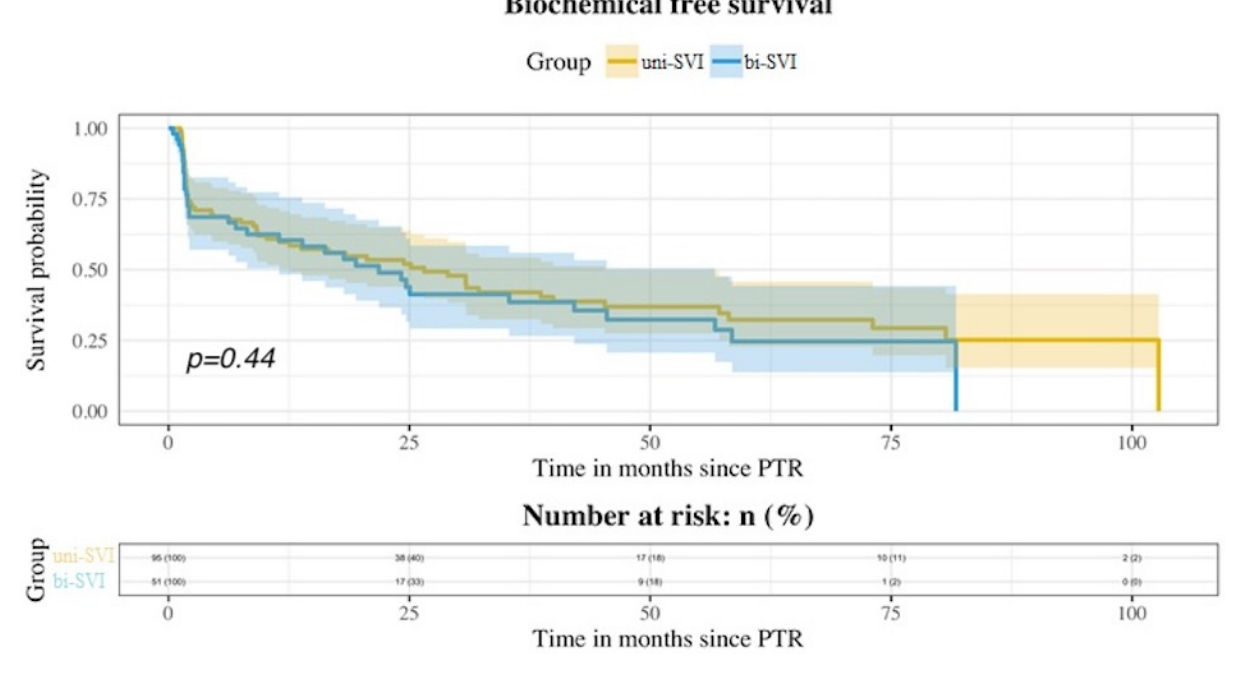
Figure 1. Kaplan–Meier curves showing BCR-free survival for both uni-SVI and bi-SVI groups.